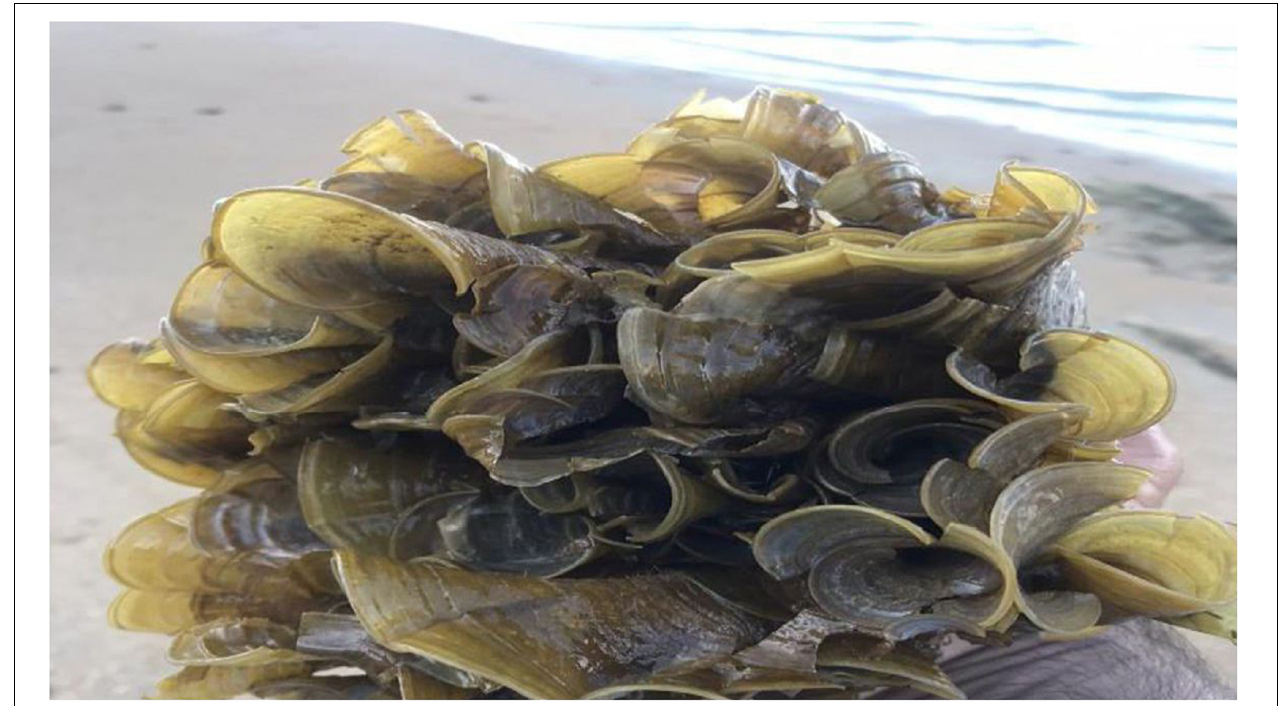
FIGURE 1 | Padina antillarum (Kützing)